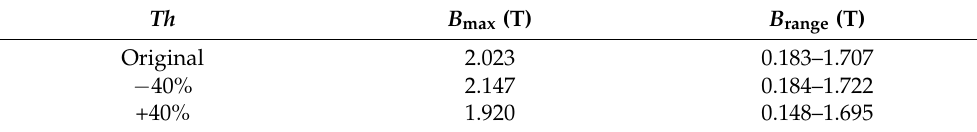
Table 5. The B max and B range by multiphysics for the various coil thickness ( Th ).